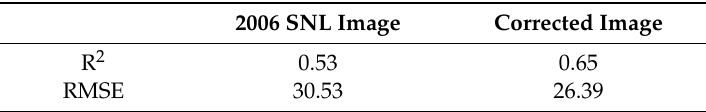
Figure 11. DN value curves in the corrected (blue), 2006 SNL (red) and RCNL (green) images extracted by the straight line (from (34.19°N, 109.18°E) to (34.40°N, 108.51°E), Xi’an–Xianyang region). Table 3. Results of the regression between the DNs of the 2006 RCNL image and those of the other images.